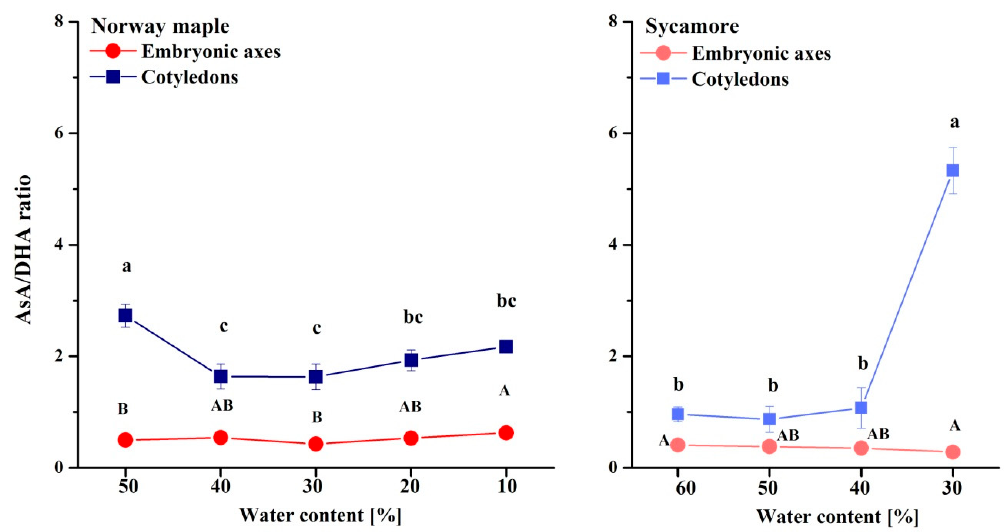
Figure 8. Ratios of reduced (AsA) to oxidized (DHA) forms of Asc in the embryonic axes and cotyledons of desiccated Norway maple and dehydrated sycamore seeds. The data are the means of three independent replicates ± the STDs. The same letters indicate groups that are not significantly different according to Tukey’s test. The capital letters refer to embryonic axes.